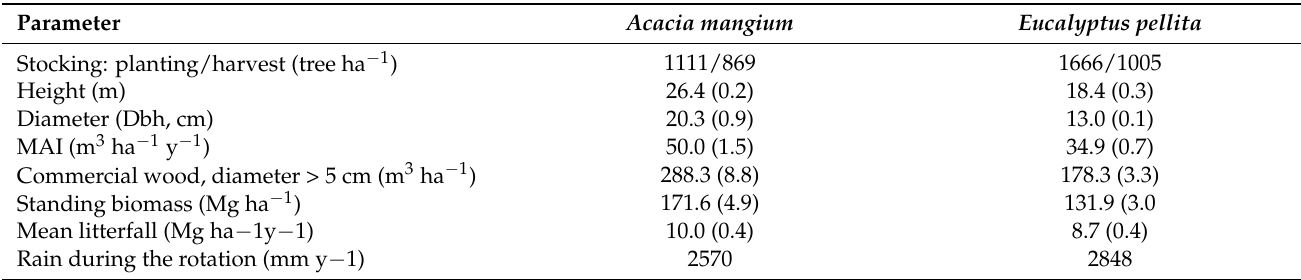
Figure 1. Wood production measured as mean annual increments (MAI) in four successive rotations. Acacia mangium in the first three and Eucalyptus pellita in the fourth. Vertical bars are SE of means. Table 2. Growth parameters of Acacia mangium in the second rotation and Eucalyptus pellita in the fourth rotation, both at age six 6